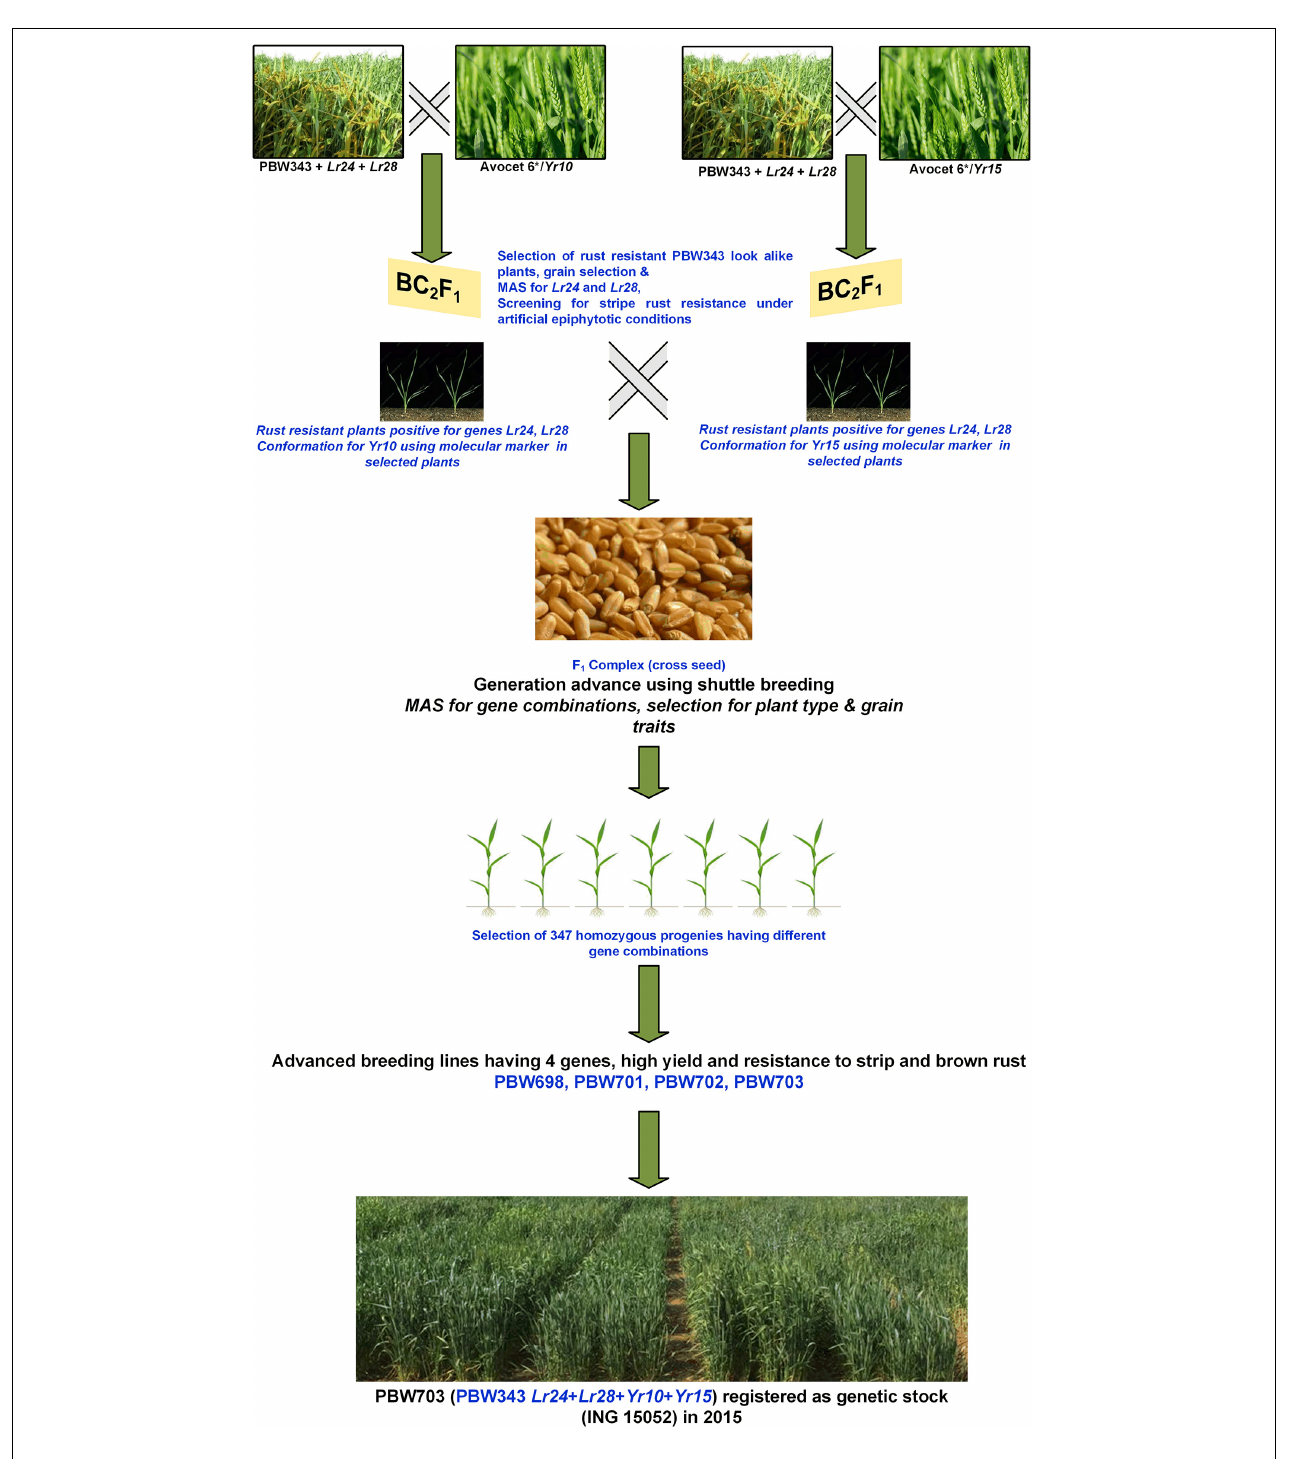
FIGURE 1 | Schematic representation of the development of the four-gene pyramided line PBW703.